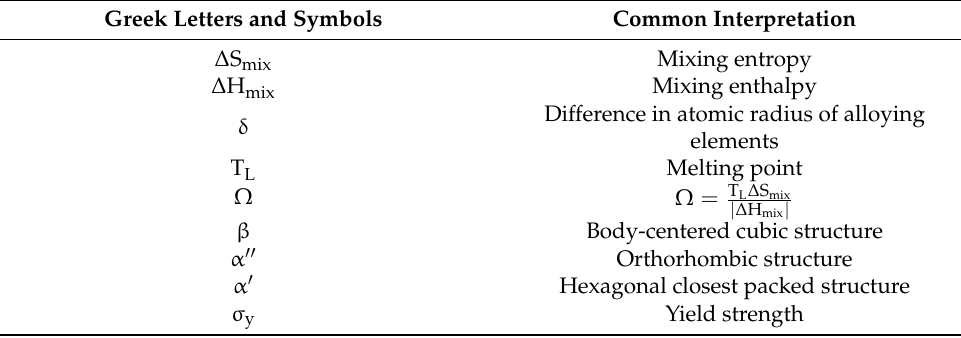
MEAs ∆ S mix (J/K · mol)